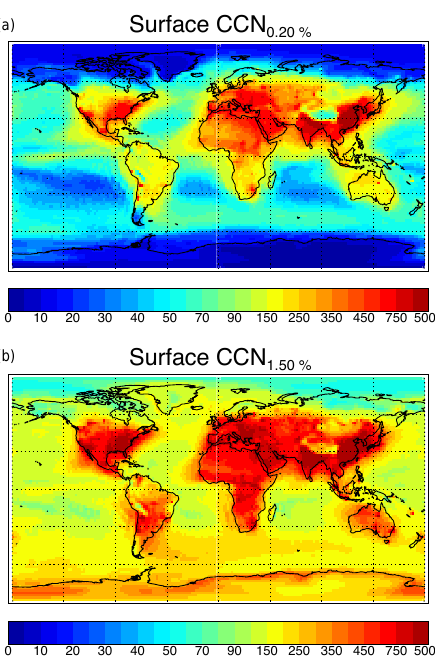
Figure 2. Annual-mean simulated a) aerosol optical depth at 550nm and b) aerosol index between wavelengths of 550nm and 865nm. Note Figure 1. Annual-mean simulated surface cloud condensation nuclei concentrations [cm  3 ] at a) 0.2% and b) 1.5% supersaturation. the non-linear scale, comparable to Fig. 1. Figure 2. Annual-mean ECHAM-HAM simulated (a) aerosol opti- Figure 1. Annual-mean ECHAM-HAM simulated surface cloud cal depth at 550nm and (b) aerosol index between wavelengths of condensation nuclei concentrations (cm − 3 ) at (a) 0.2% and 550 and 865nm. Note the non-linear scale, comparable to Fig. 1. (b) 1.5% supersaturation.